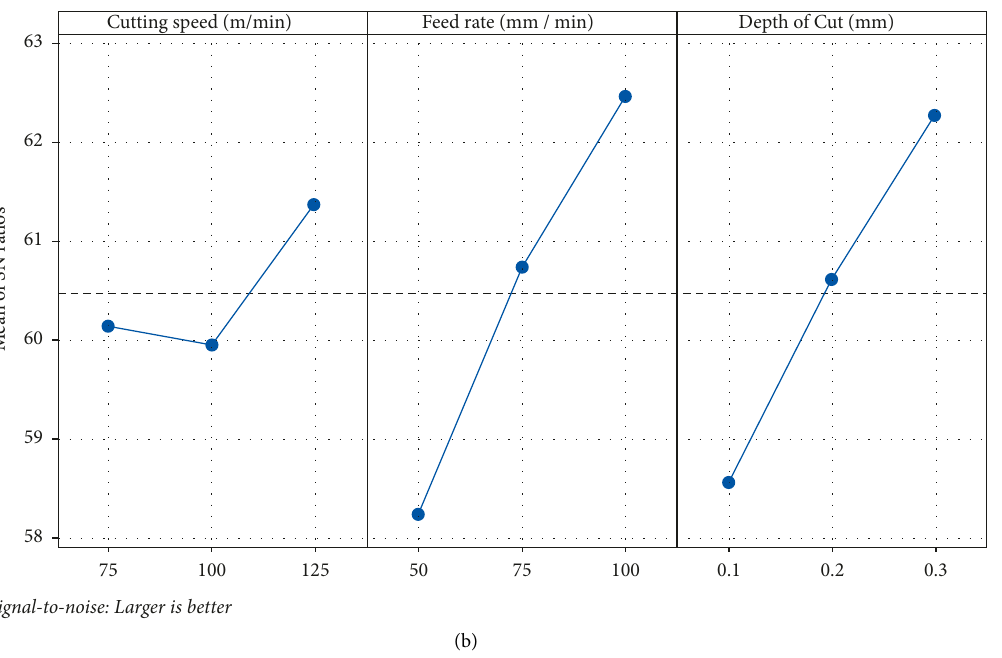
Figure 5: (a) Means of S/N ratio plot for the material removal rate of milled DMLS plate. (b) S/N ratio plot for the material removal rate of milled DMLS Table 6: Response table for means for each cutting condition of Inconel 718 alloy. Level